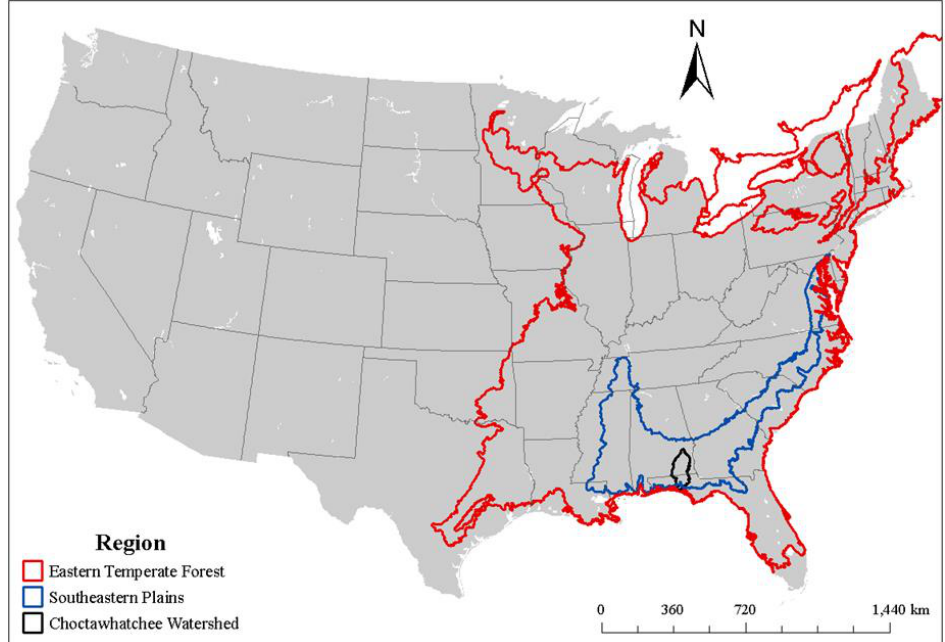
Figure 5. A location map with boundaries of the Choctawhatchee River Watershed, Southeastern Plains Ecoregion, and Eastern Temperate Forest Ecoregion overlaid in the United States. Table 3 lists the average total richness and standard deviation values for each LULC.